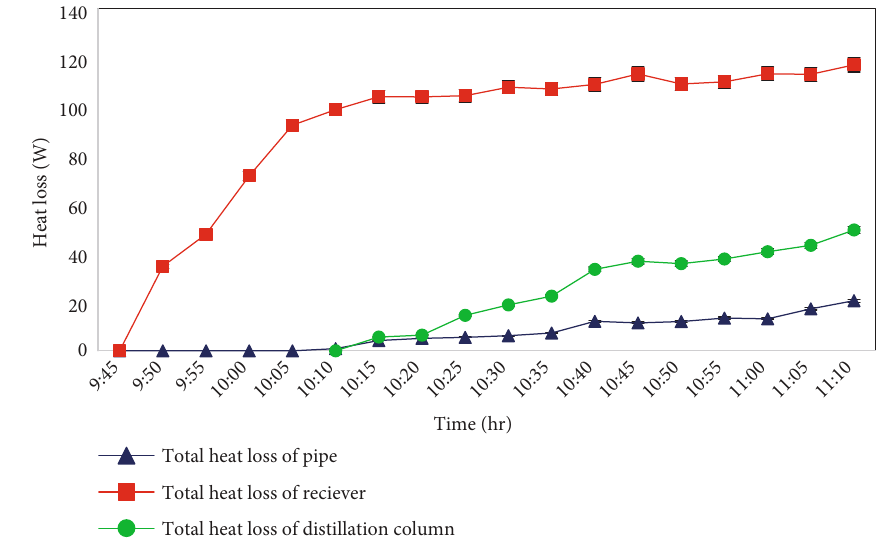
Figure 10: Total heat loss of the system.